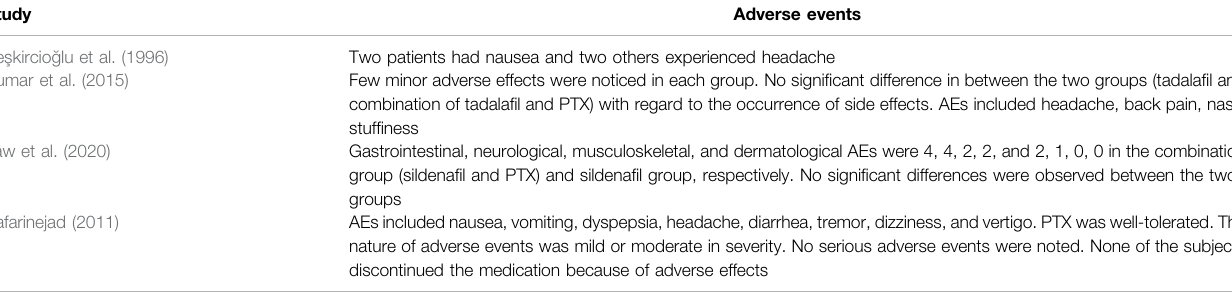
TABLE 5 | Summary of AEs in the treatment of ED and male infertility with oral PTX. Study Adverse events